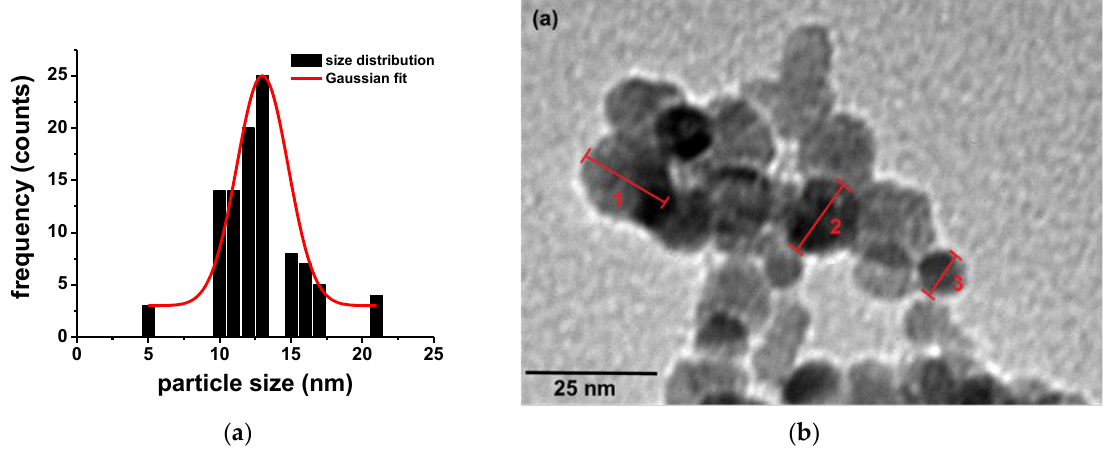
Figure 2. ( a ) TEM image of the Fe 3 O 4 @Au pNPs, ( b ) and their size distribution.